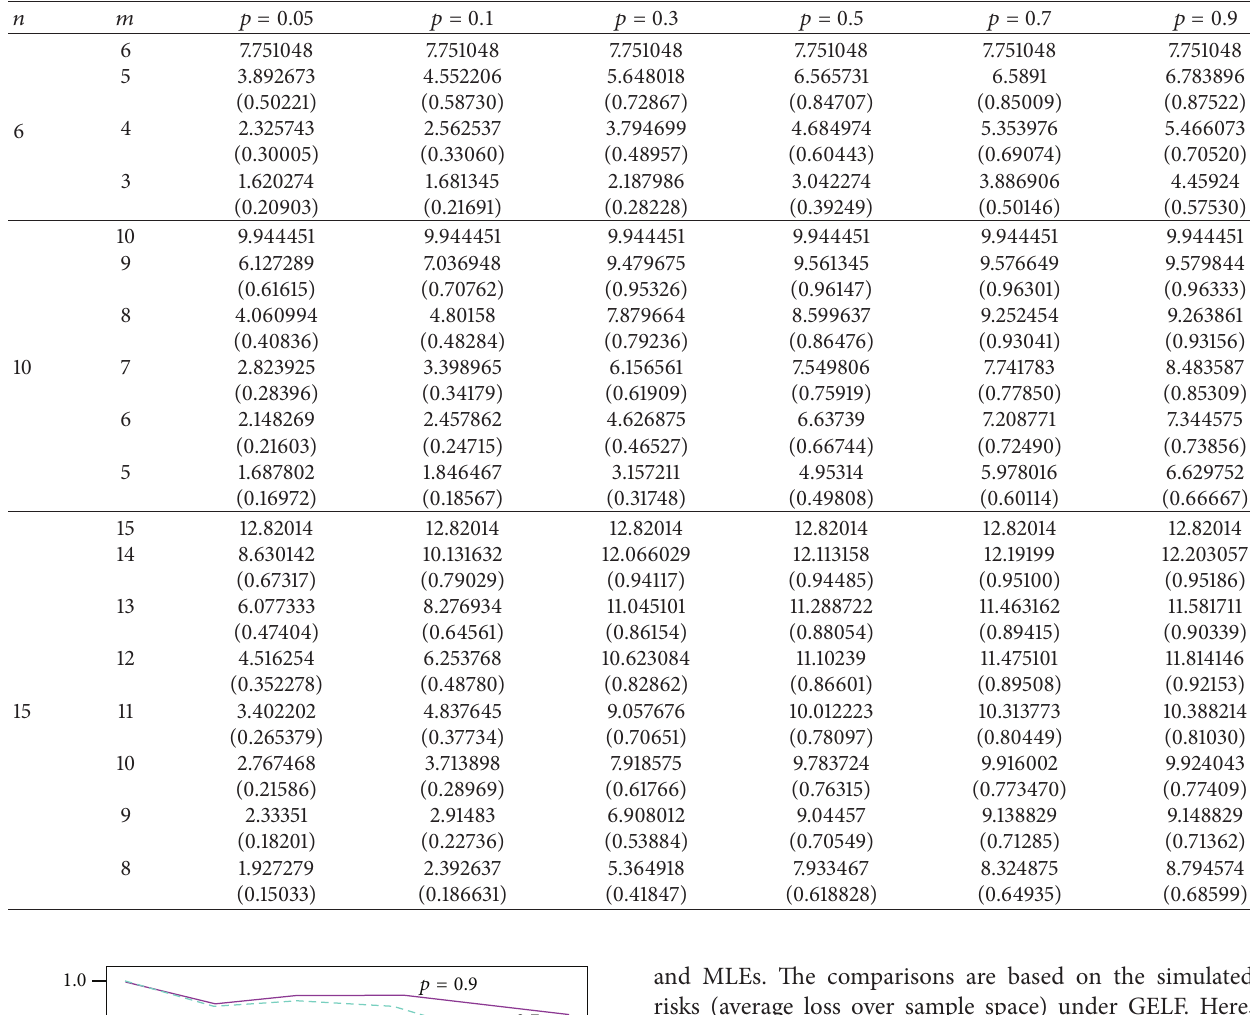
(in the brackets) for (𝛼, 𝜆) = (2,2) under PT-II CBR. REET